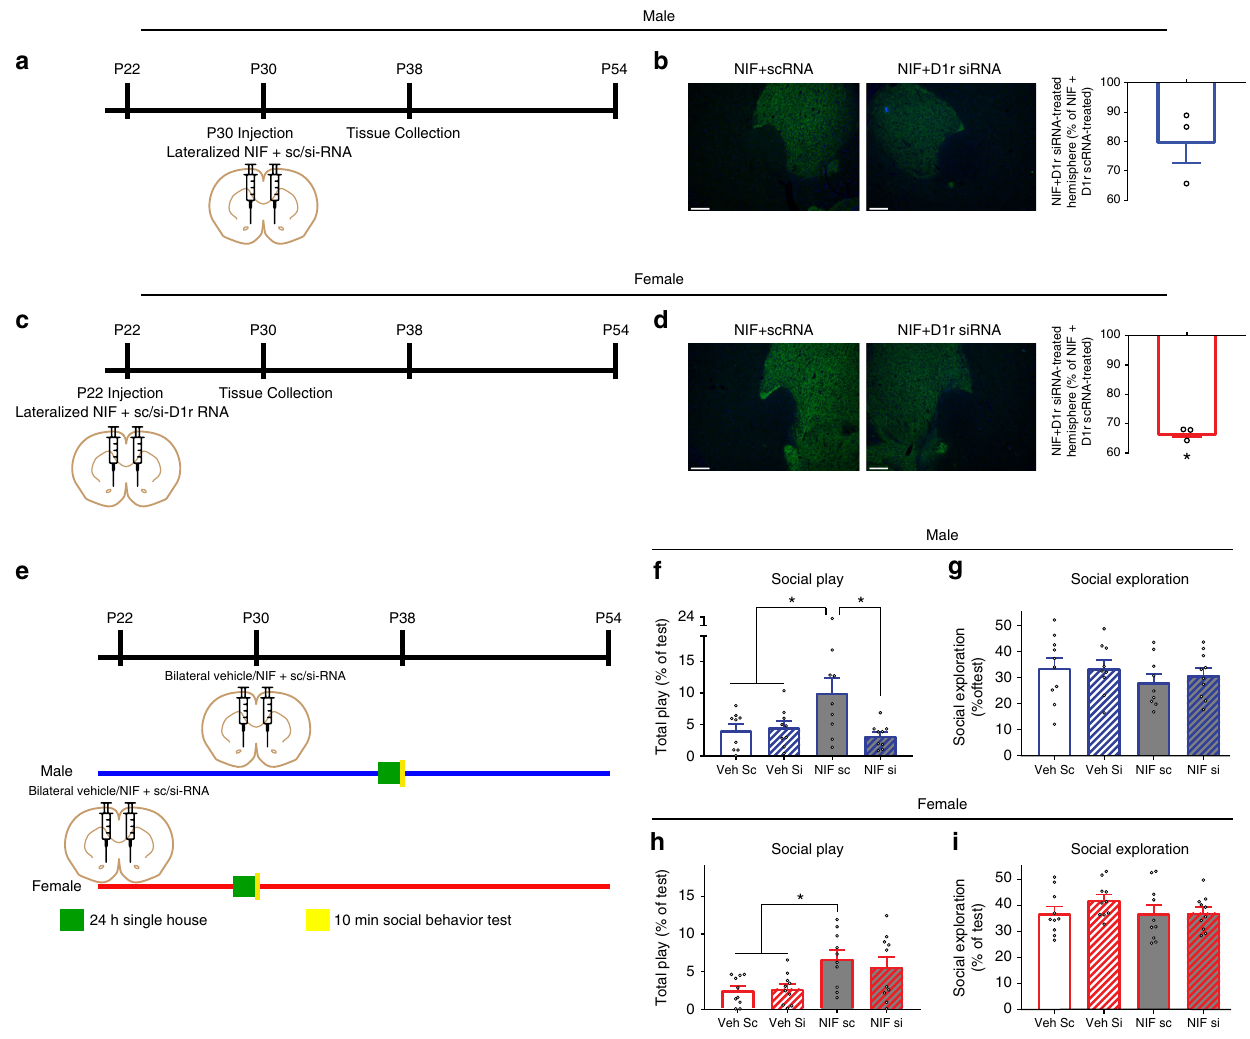
Fig. 5 C3 – C3R regulation of D1rs regulates male, but not female, social play behavior. To determine if disrupting C3 – C3R interactions via NIF increases play in a D1r-dependent manner, we utilized siRNA against rat D1r (200 µ M) or scRNA controls. a P30 males were co-injected with NIF + D1r siRNA in one hemisphere and NIF + scRNA in the contralateral hemisphere, and then D1r immunoreactivity was assessed at P38. b In the presence of NIF, D1r siRNA was capable of decreasing D1r levels relative to NIF + scRNA within-animal control hemispheres (~20%; Table 5A). c P22 females were injected with NIF + D1r siRNA in one hemisphere and NIF + scRNA in the contralateral hemisphere, and then D1r immunoreactivity was assessed at P30. d In the presence of NIF, D1r siRNA was capable of decreasing D1r levels relative to NIF + scRNA within-animal control hemispheres (~30%; Table 5B). Representative images precede histograms; scale bar equals 100 µ m. n = 3/sex. e Experimental design: P30 males and P22 females were bilaterally microinjected into the NAc with either Vehicle + scRNA (Veh sc), Vehicle + D1r siRNA (Veh si), NIF + scRNA (NIF sc), or NIF + D1r siRNA (NIF si). At P37 and P22, animals were single-housed for 24 h, and then a novel age- and sex-matched conspeci fi c was introduced into their home cage for 10 min social behavior tests ( n = 9 – 10/sex/treatment). Males: f NIF + scRNA increased social play behavior in males, which was eliminated by D1r siRNA (NIF si; Table 5C). g No treatment changed social exploration behavior (Table 5D). Females: h NIF + scRNA increased social play behavior in females, which was not affected by D1r siRNA (NIF si; Table 5E). i No treatment changed social exploration behavior (Table 5F). Immunohistochemical data were calculated as in Fig. 2 and analyzed with two-tailed one-sample t -tests. Behavioral data were analyzed with one-way ANOVAs and Holm-Sidak ’ s post-hoc comparisons. Histograms portray the mean ± SEM with individual data points overlaid. Signi fi cant one-sample t -tests from 100 ( b , d ) and post-hoc Holm-Sidak t -tests ( f – i ) ( p < 0.05) comparisons are delineated with an asterisk. All statistics are in Table